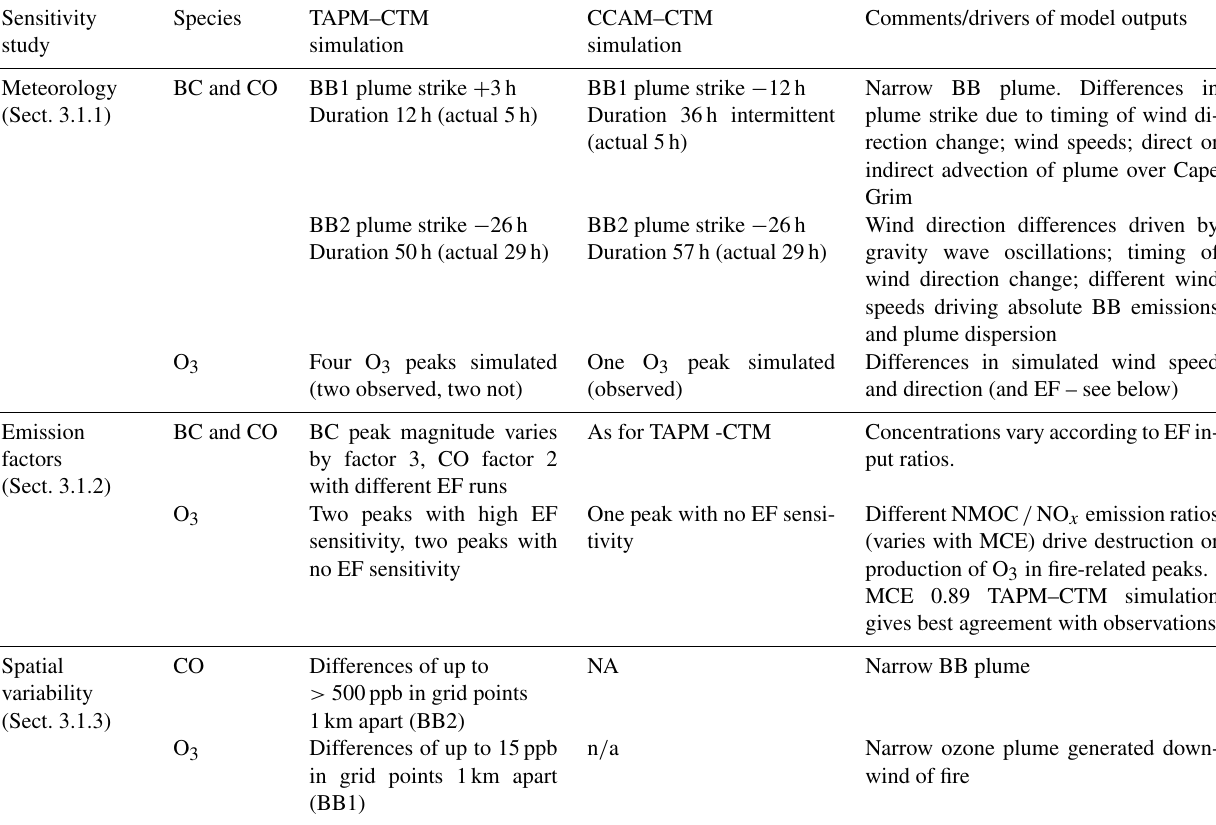
NA: not available. Table 2. Summary of sensitivity study results, including meteorology, emission factors and spatial variability. Sensitivity